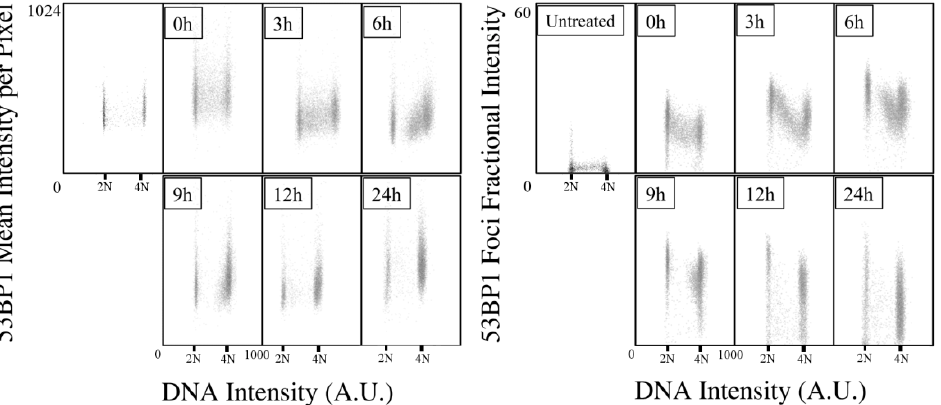
Figure 3. Image cytometry analysis of the IR-induced 53BP1 content and foci kinetics after X-ray irradiation. Analysis of protein content per nucleus, and of the fraction of the 53BP1 intensity localized in foci versus the total fluorescence of the nucleus in relation to the DNA content at the indicated time-points.